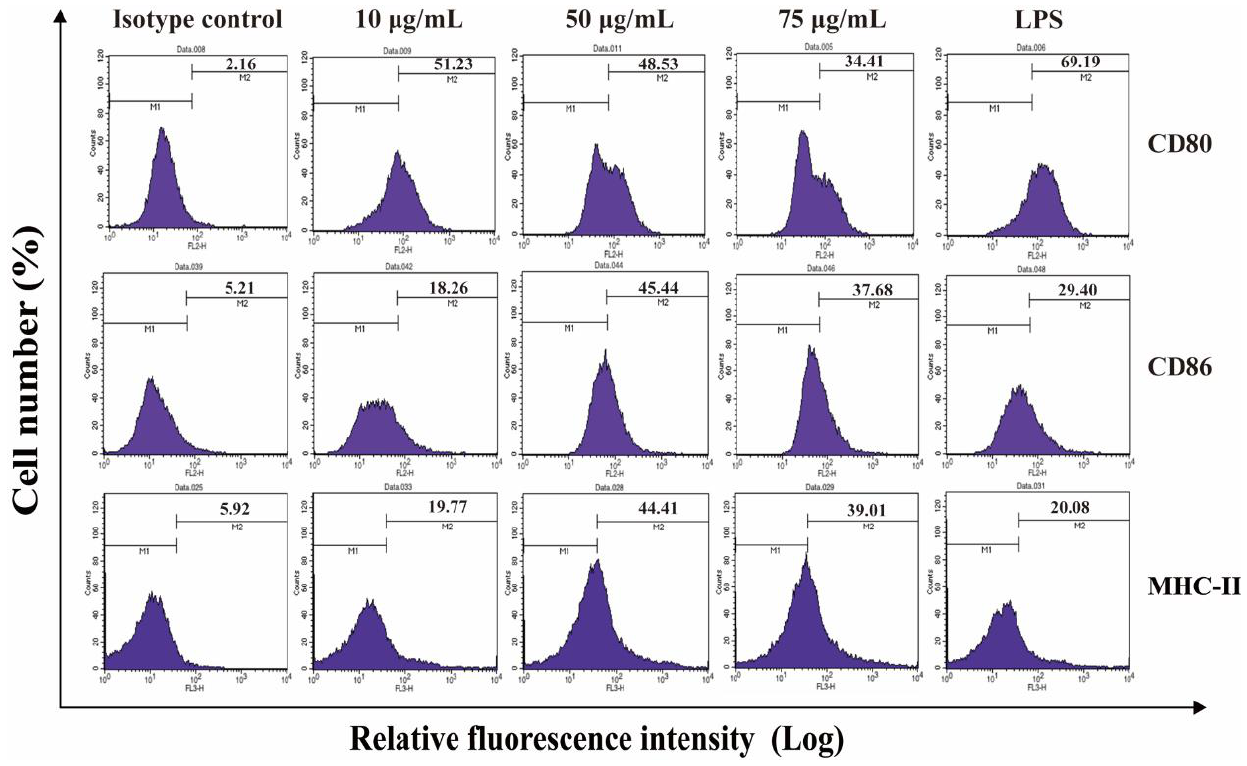
Figure 3. The expression detection results of different maturation markers were detected by flow cytometry and the isotype controls in panels are related to the determination background.